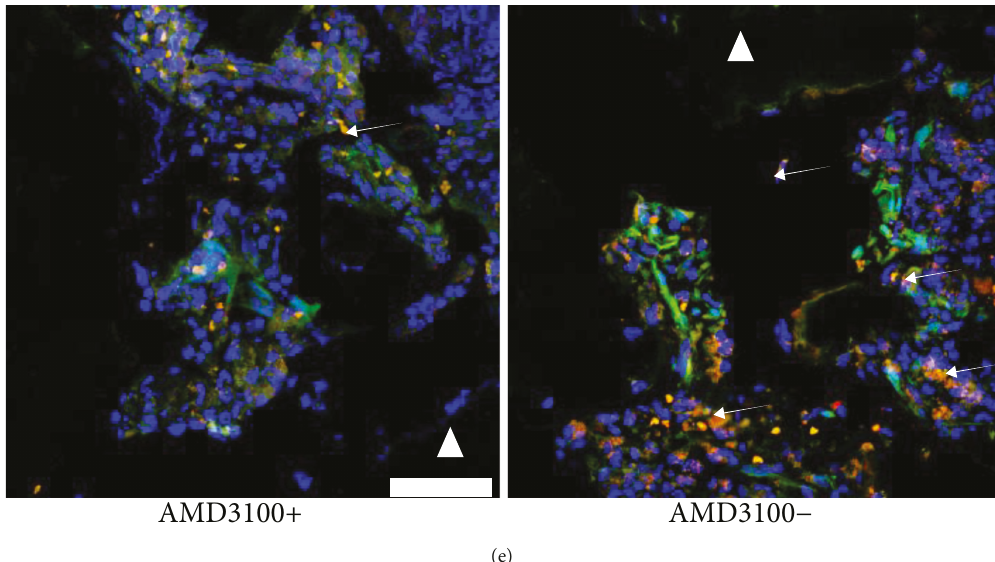
Figure 4: The SDF-1/CXCR4 axis promoted the migration of GFP + /CD44 + bone marrow (BM) cells. (a) Representative images of migrated BM cells in di ff erent groups. The quanti fi cation of the migrated BM cells is shown as a bar graph ( n = 5 ). ∗ P < 0 05 . ∗∗ P < 0 01 . (b) Comparison of CXCR4 protein expression after SDF-1 induction. After migration stopped, BM cells were collected and analyzed by western blot. (c) Postoperatively, the concentration of SDF-1 in di ff erent tissues was measured daily using ELISA. The di ff erent tendency is presented on the line chart. (d) FACS analysis of the proportions of CD44 + cells in PB. Postoperatively, cells collected from peripheral blood (PB) of mice receiving AMD3100 or not were incubated with fl uorescently conjugated antibodies against CD44 and analyzed using the CytoFLEX software. The quanti fi cation comparison is shown as a bar graph ( n = 3 ). ∗∗ P < 0 01 . (e) Representative images of in vivo migration of GFP + /CD44 + cells towards TECs. The recruitment of GFP + /CD44 + cells was signi fi cantly reduced after systematic delivery of the AMD3100 group. White triangle, implant area; white arrows, GFP + /CD44 + cells; scale bar, 50mm. TECs, tissue-engineered constructs. MSC-CM, conditioned media of mesenchymal stem cells. BCM, basic culture